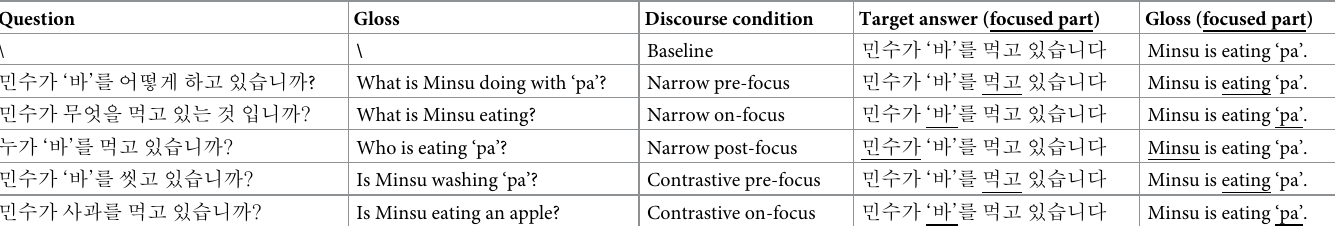
Table 1. Examples of Korean target syllables in various discourse conditions (focused parts are highlighted underlined and in bold). Question